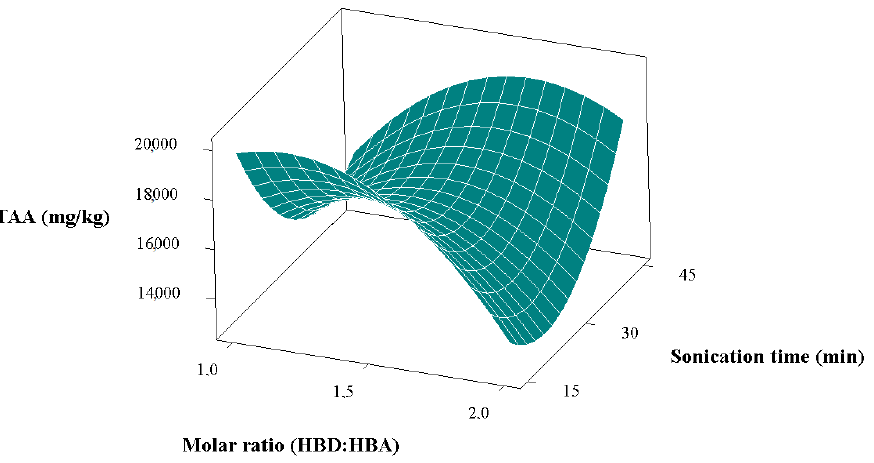
Figure 1. Variation of total individual amino acids (TAA) values with sonication time and molar